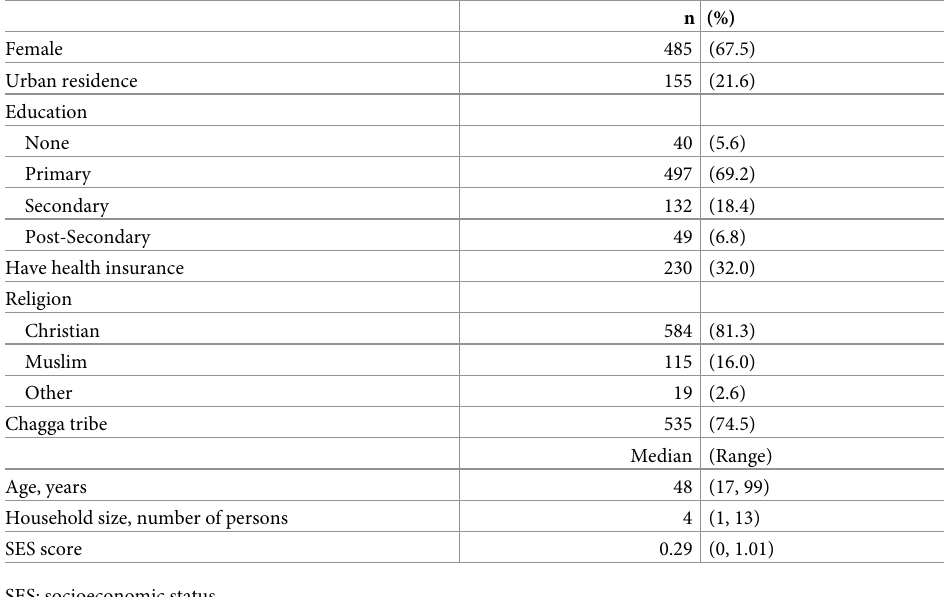
Table 1. Sociodemographic features of household survey respondents, Moshi Urban, Moshi Rural, and Hai Dis- tricts, 2018 (N =